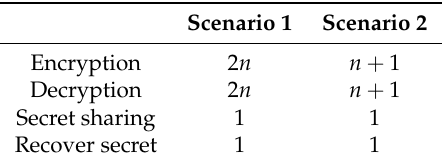
Table 3. Scenario analysis.